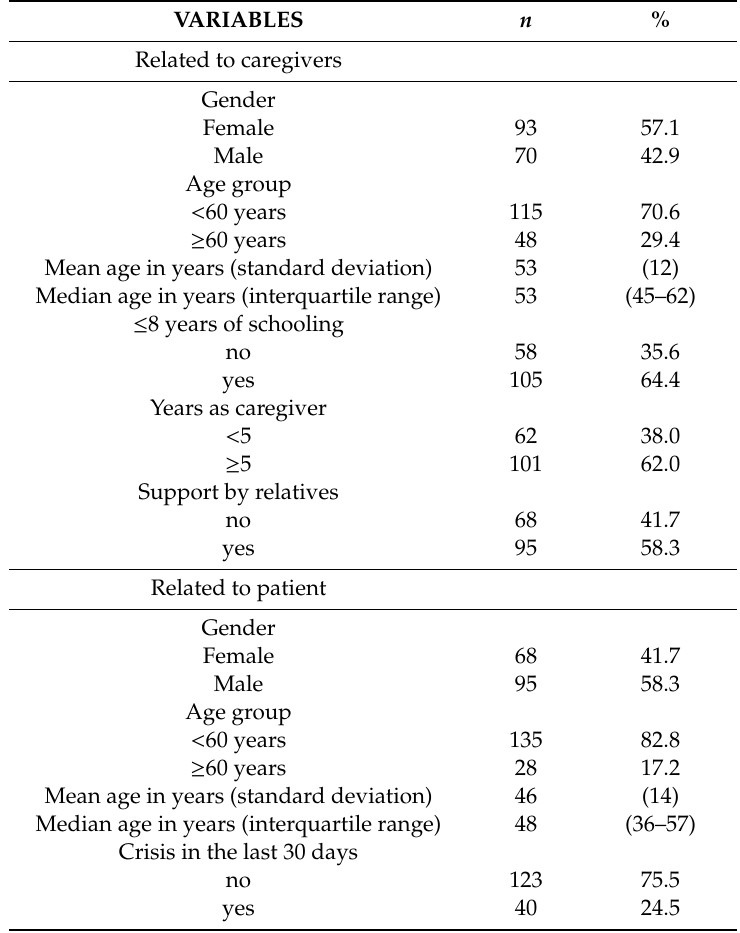
Table 1. Description of the predictor variables for quality of life and for marital satisfaction. VARIABLES n